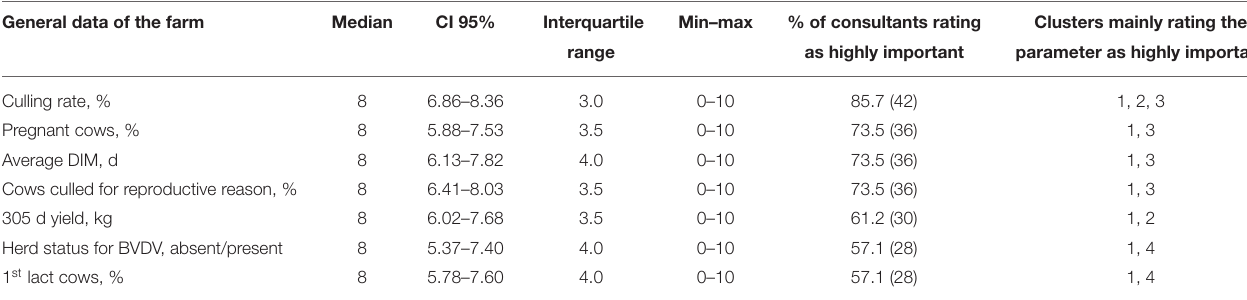
TABLE 2 | Parameters evaluated as highly important (range 8–10) on Section 2: General Data of the Farm used by, at least, 50% of the consultants surveyed after hierarchical clustering analysis. General data of the farm Median